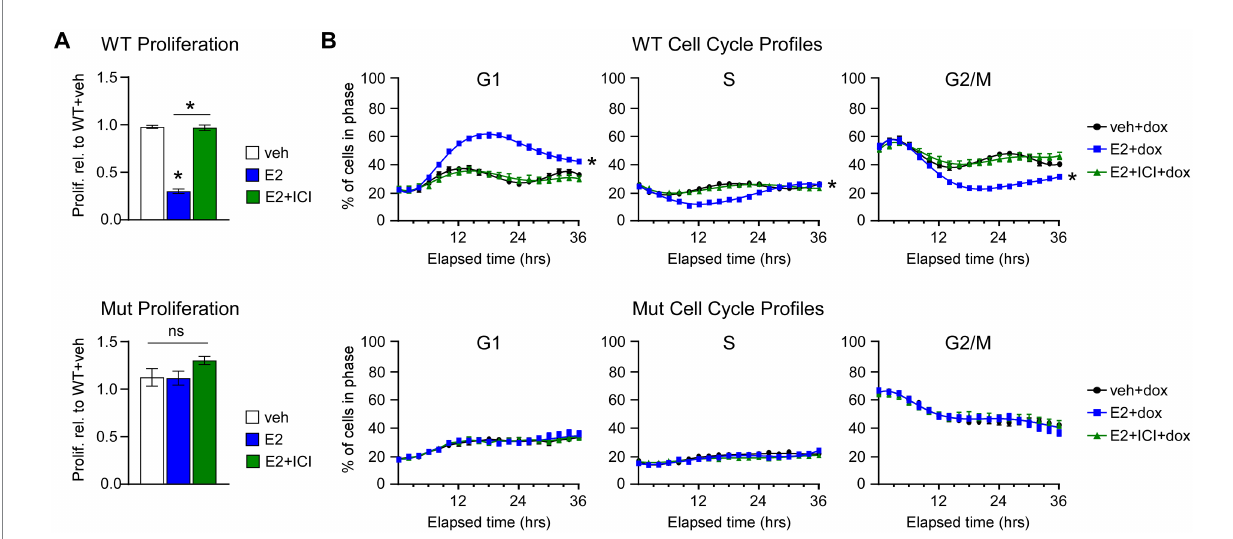
FIGURE 2 Effects of WT and ER β DBD-Mut on proliferation and cell cycle progression of MDA-MB-231 cells. (A) Proliferation of WT ER β and ER β DBD-Mut (Mut) MDA- MB-231 cells in the presence of dox and veh, E2, or E2 + ICI treatment. * Indicates p < 0.05 relative to WT + veh or between indicated treatments (Student’s t -test). (B) Real-time assessment of ER β WT and Mut MDA-MB-231 cell cycle progression in the presence of dox and veh, E2, or E2 + ICI. * Indicates p < 0.05 relative to veh treat cells